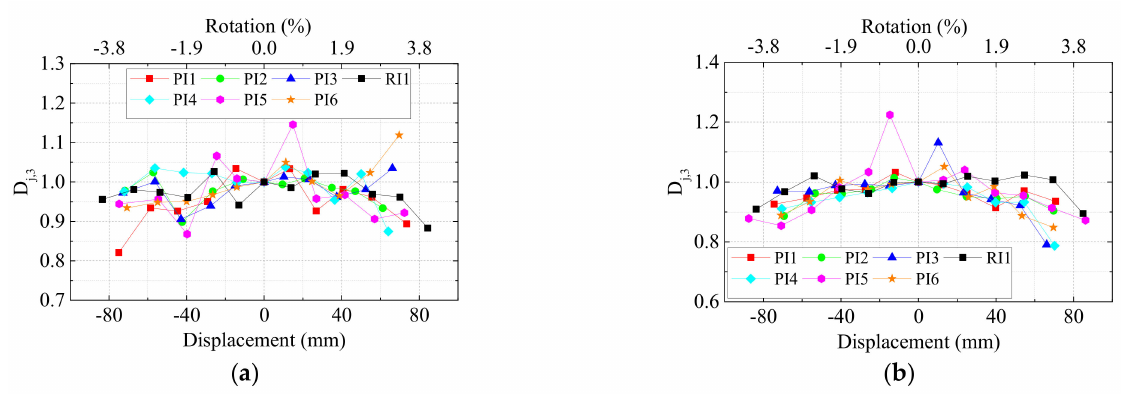
Figure 11. Strength degradation coefficient D j ,3 of ( a ) left beams and ( b ) right